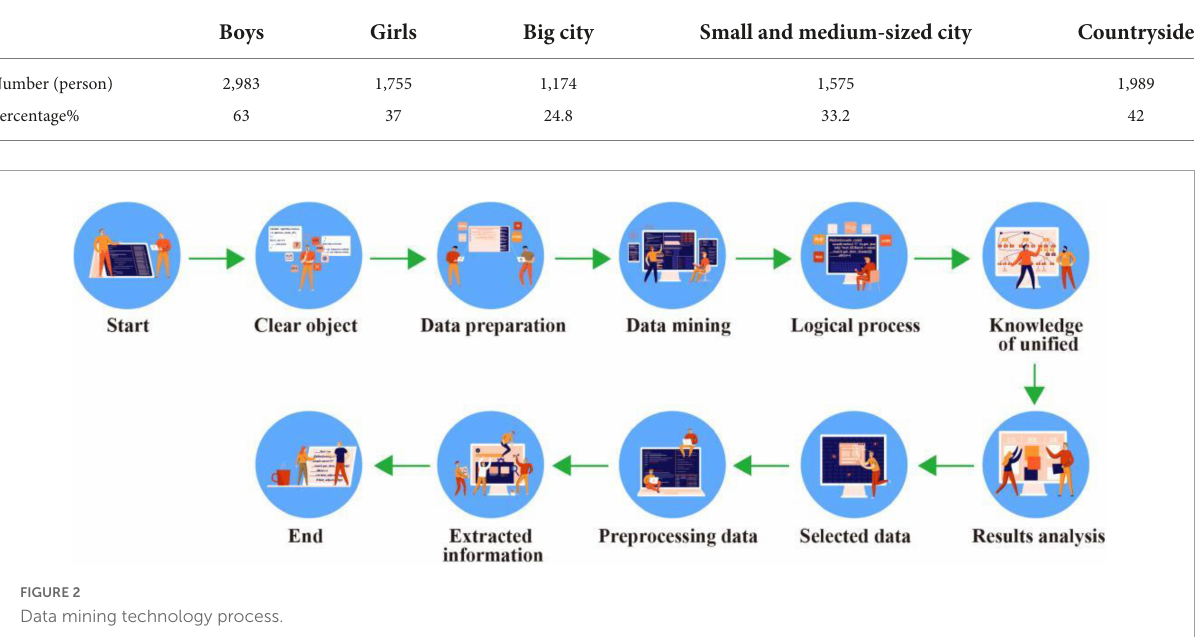
FIGURE2 Data mining technology process.